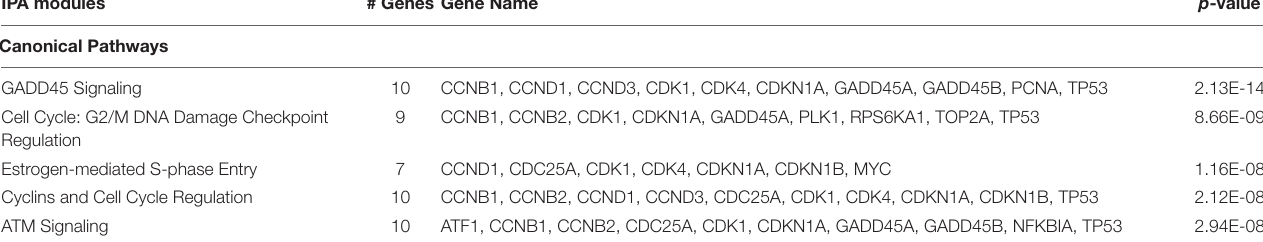
TABLE 2 | IPA based on 200 high-frequent genes of correctly predicted transcriptomic profiles. IPA